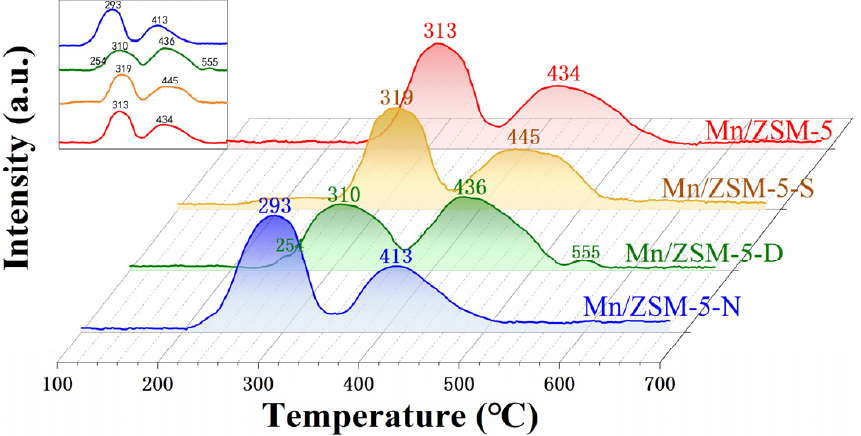
Figure 9. H 2 ‐ TPR curves of catalysts. Figure 9. H 2 -TPR curves of